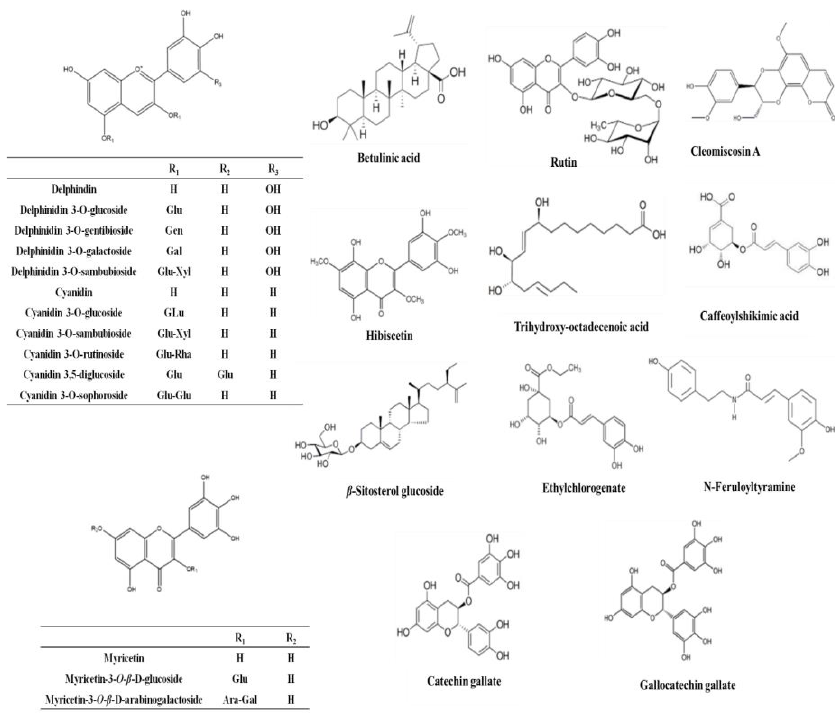
Figure 3. Structures of representative compounds detected in the Hibiscus schizopetalus LC-MS profile.